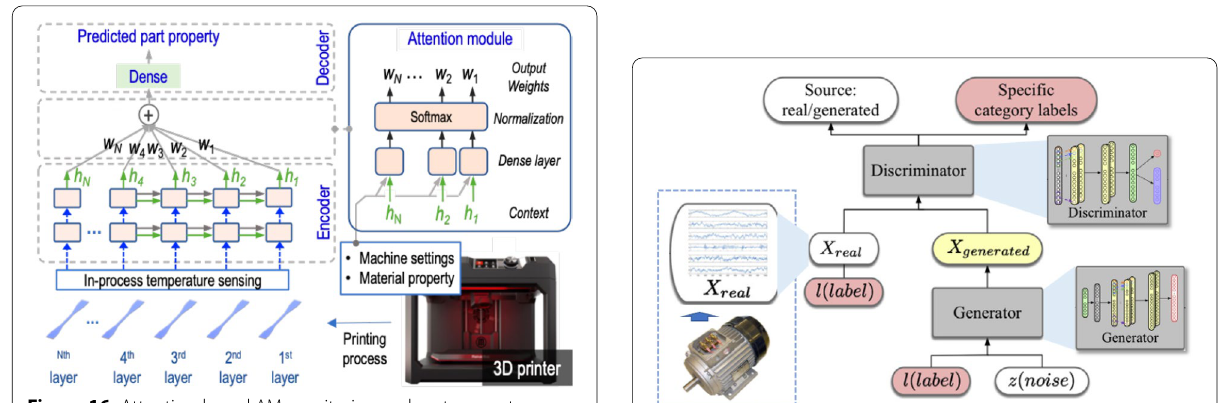
Figure 16 Attention-based AM monitoring and part property prediction [108] Figure 17 Auxiliary classifier GAN, adapted from Ref.